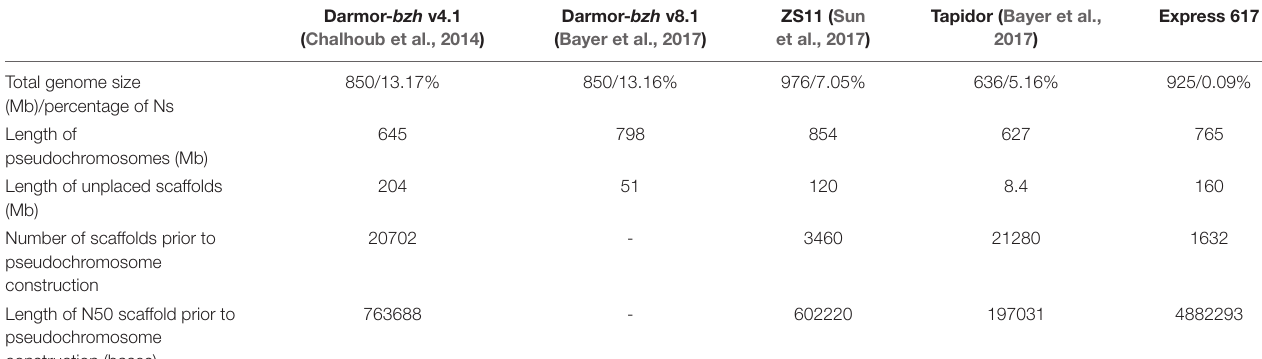
TABLE 1 | Assembly statistics of the Express 617 genome in comparison with three previously published B. napus genome